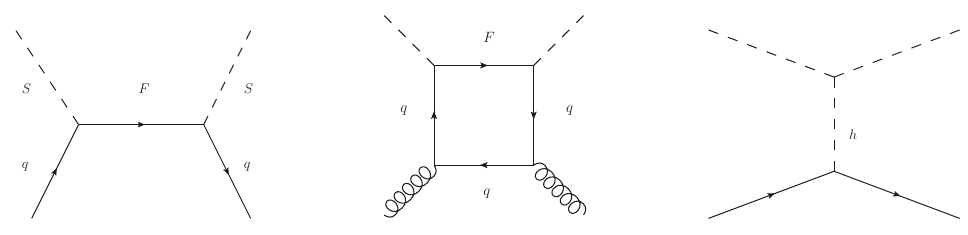
Figure 7 . Set of representative Feynman diagrams contributing to the e(cid:11)ective DM nucleon